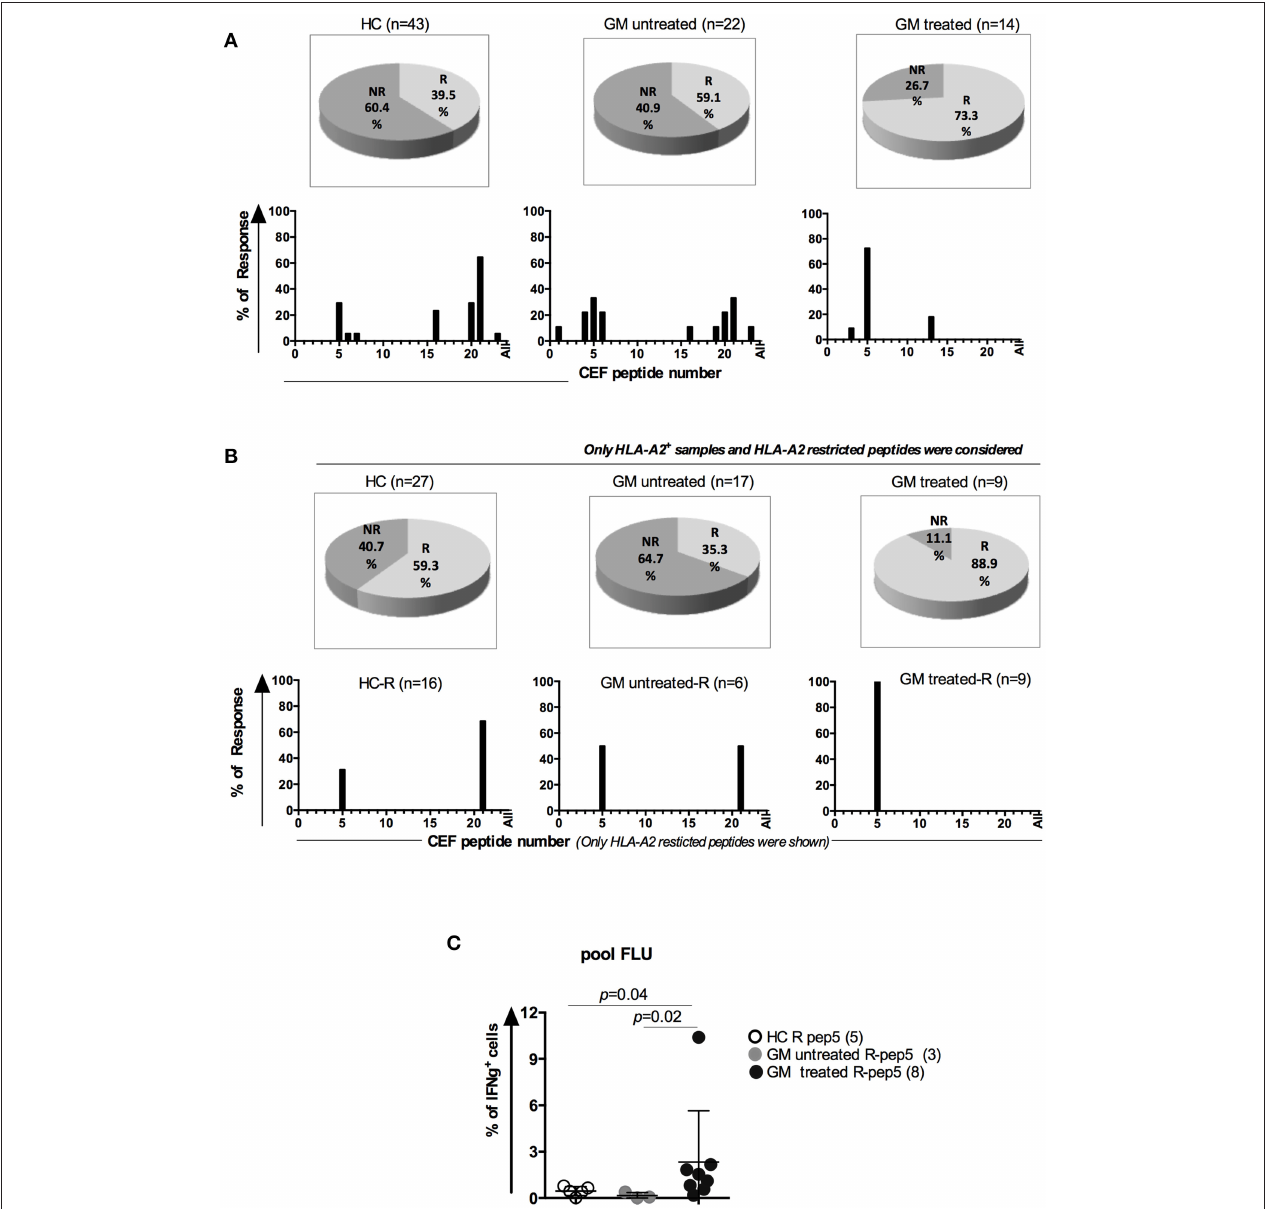
FIGURE 3 | Enhanced antigen-specific memory T cell responses in GM treated RA patients. (A) Upper panel : Percentages of responders (R) and non-responders to CEF peptide stimulation in three groups. Lower panel: peptide distribution in responders (B) Upper panel : Percentages of HLA-A2 + R and NR to HLA-A2 restricted peptides in three groups; Lower panel: peptide distribution in HLA-A2 + responders. (C) Frequencies of IFN γ + CD8 + T cells in responders to the peptide GILGFVFTL (FLU-A2) in GM treated patients ( n = 8), GM untreated patients ( n = 3) and HCs ( n =